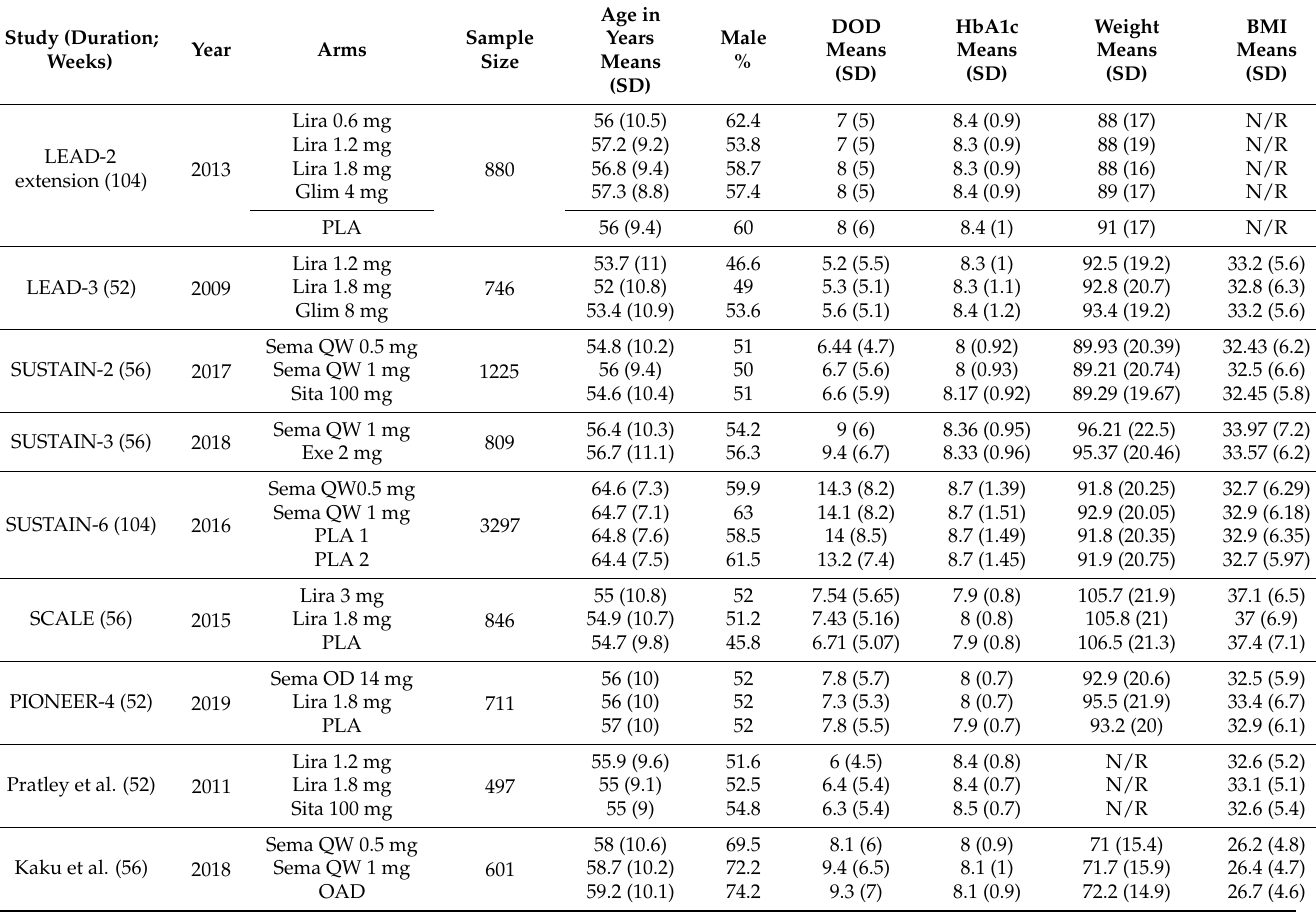
Table 2. Baseline characteristics of included